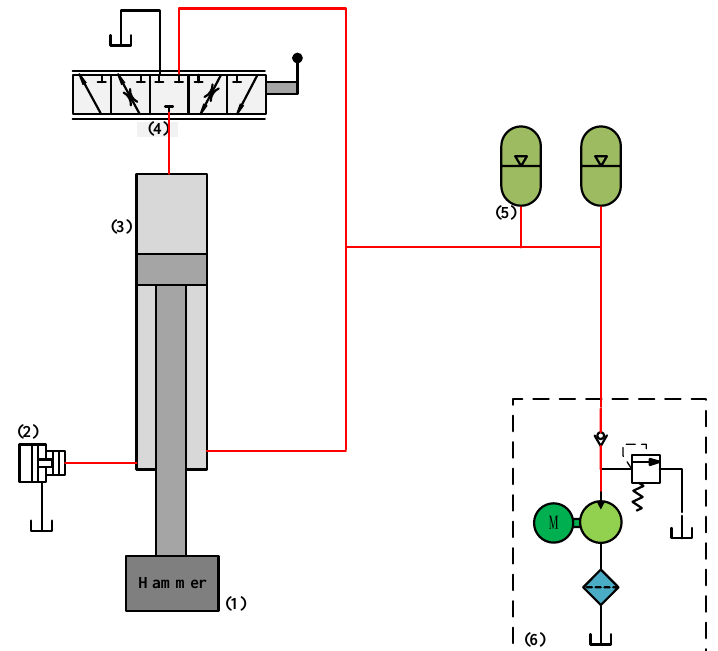
Figure 2. Schematic diagram of the all-hydraulic free forging hammer. (1: hammerhead; 2: relief valve; 3: working cylinder; 4: manual spool valve; 5: accumulator group; 6: hydraulic power unit).